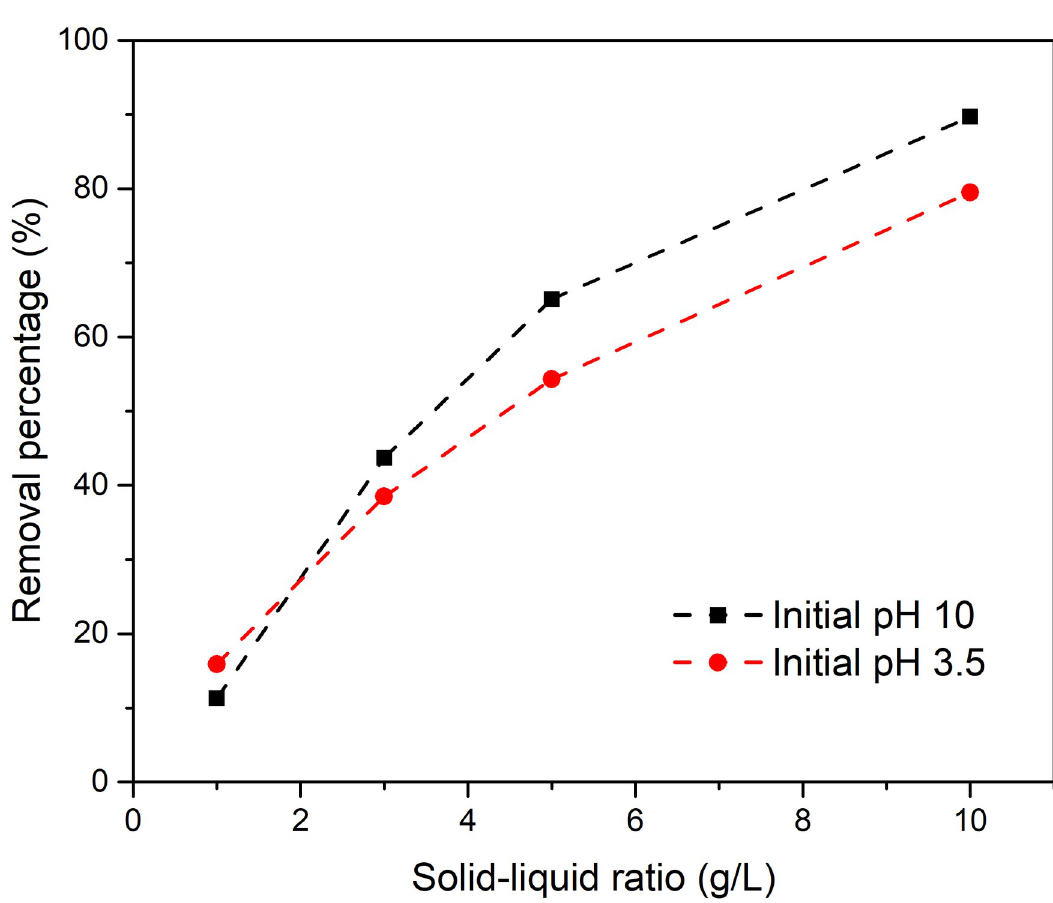
Fig 6. Effect of initial pH and solid–liquid ratio on percentage of fluoride removed; initial pH of 3.5 and 10.